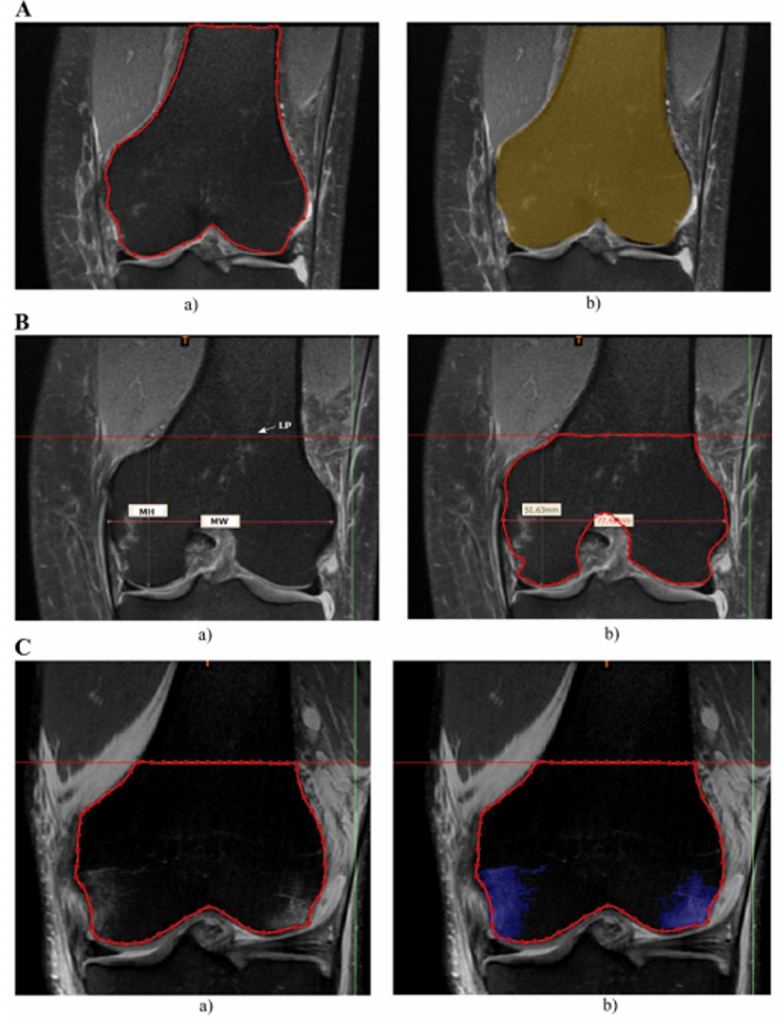
Figure 2. ( A ) Region of interest (ROI) for the femur: a) the edges of the ROI and b) the ROI mask. ( B ) Methodology of determining the total volume (TVI): ( a ) measurement of maximum width (MW) and maximum height (MH) and ( b ) determination of the ROI in TVI. ( C ) Bone bruise (BB) segmentation process: ( a ) coronal cross-section of the femur with BBs and ( b ) coronal cross-section of the femur with segmented